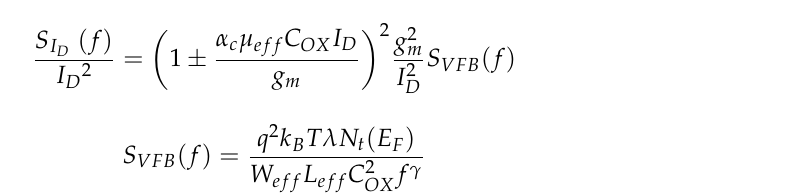
Figure 8. Normalized fluctuation power spectral intensity (